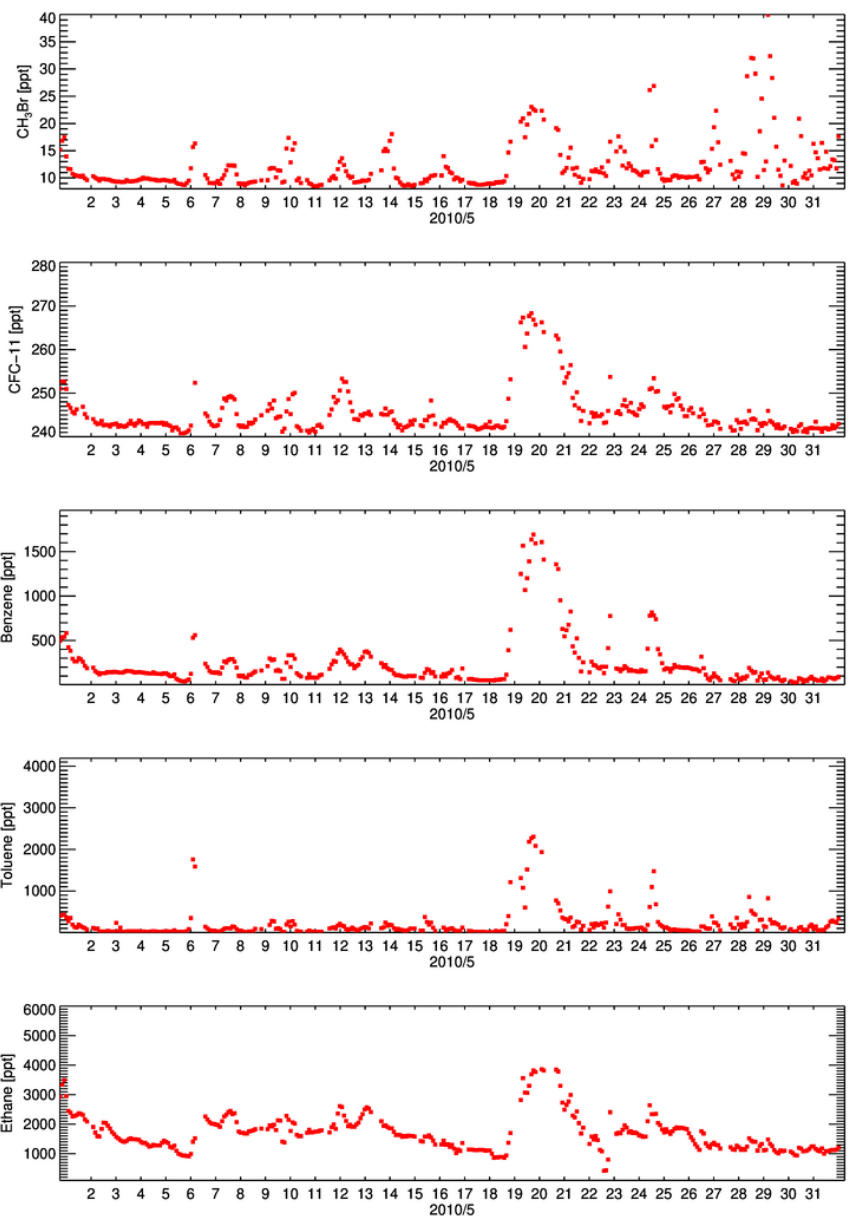
Figure 6. Observed mole fractions of CH 3 Br, CFC-11, benzene, toluene, and ethane at Gosan during May 2010; note the highly correlated pollution events between CH 3 Br and CFC-11 and also the mole fractions of VOCs (benzene, toluene, and ethane), which are likely related to the biomass burning and general anthropogenic combustion processes increasing